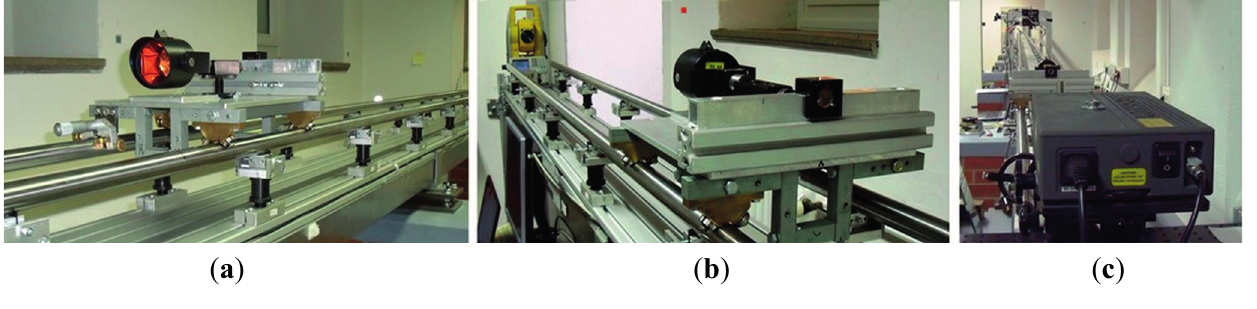
Figure 7. Baseline with interferometer (TU Dresden): ( a ) the interferometer’s carriage with the prism; ( b ) the interferometer’s carriage with the prism and the total station; ( c ) the interferometer Renishaw